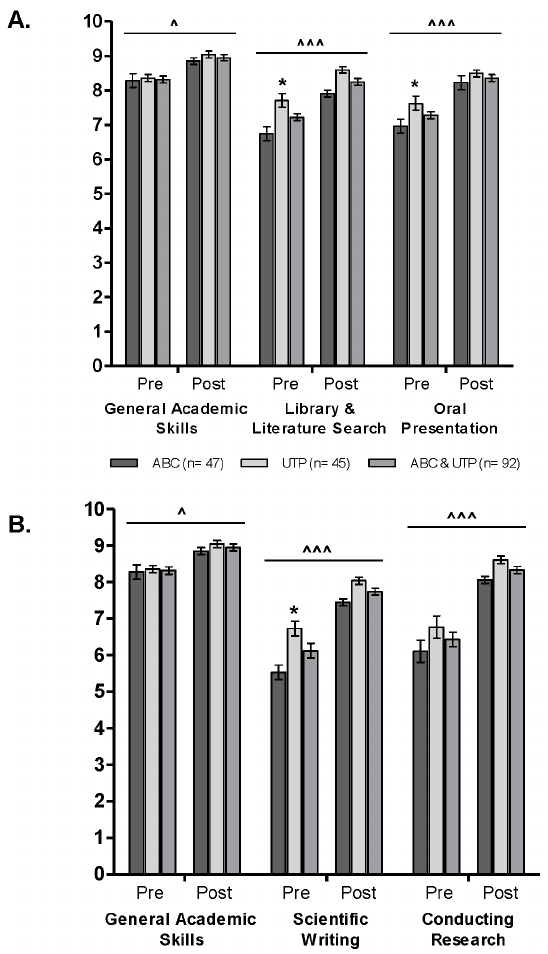
Figure 1. ABC and UTP participant self-assessment of research skills before and after the summer research experience